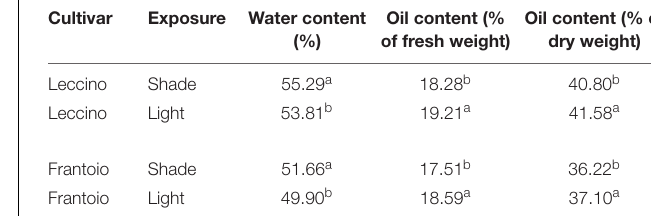
TABLE 2 | Water and oil content at harvesting time (20th November).